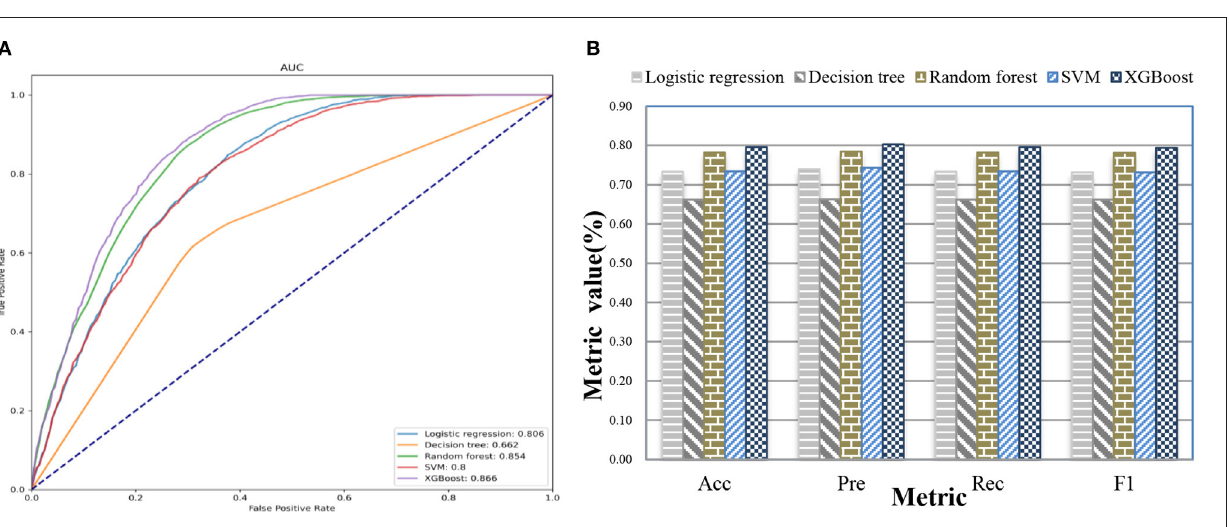
Frontiers in Public Health |